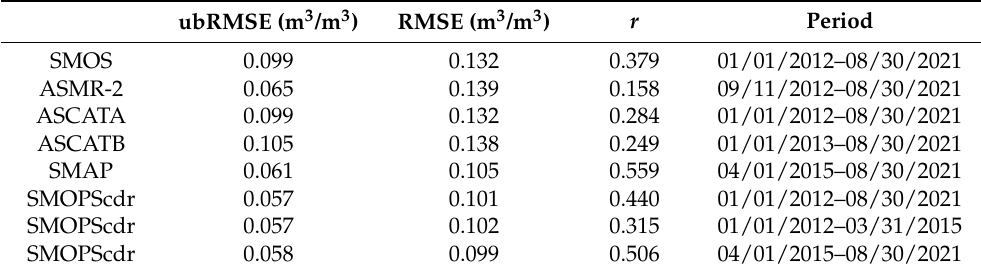
Table 1. CONUS domain-averaged RMSE, ubRMSE and correlation coefficients ( r ) for SMOPScdr and the original individual satellite soil moisture data products compared with SCAN measurements, as well as the corresponding statistical